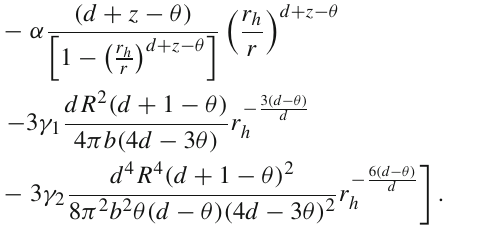
dash ), α = − 0 . 5, γ 1 = 0 ( red dot ), α = 0, γ 1 = 0 ( red solid ), α = 0, γ = 0 . 5 ( blue dash dot ), α = 0, γ 1 = 0 ( red 1